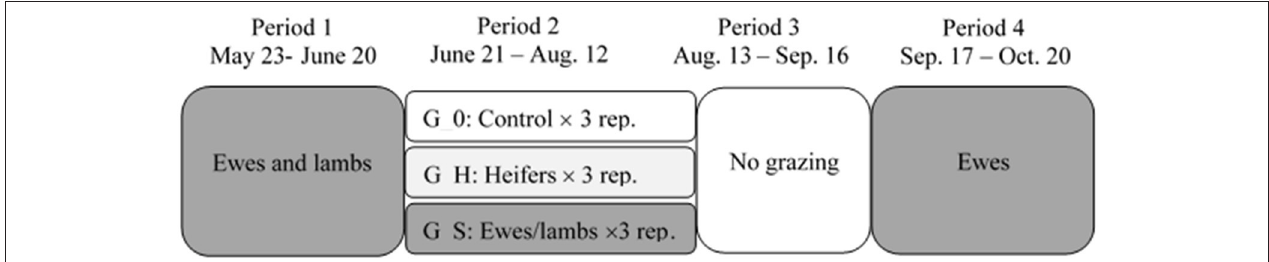
FIGURE 1 | Illustration of periods of the growing season and grazing management. In Period 2, the area was subjected to the experimental treatments G_0 Control (no grazing), G_H Heifers grazing, and G_S ewes grazing with their offspring, each replicated three times.